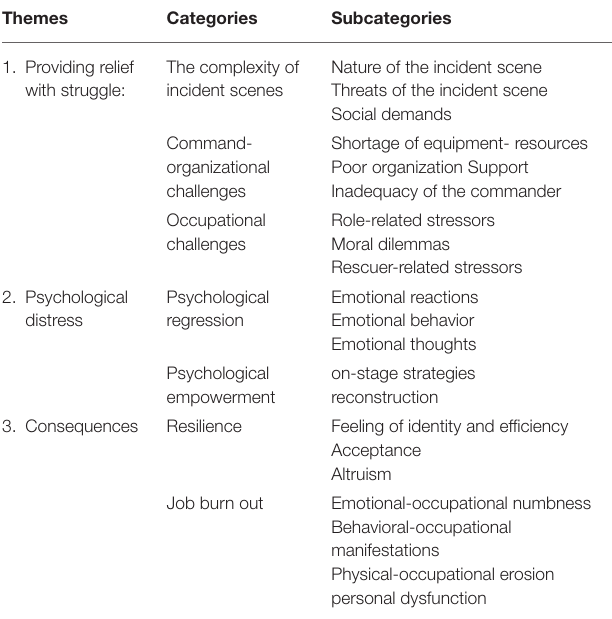
TABLE 2 | The main category and